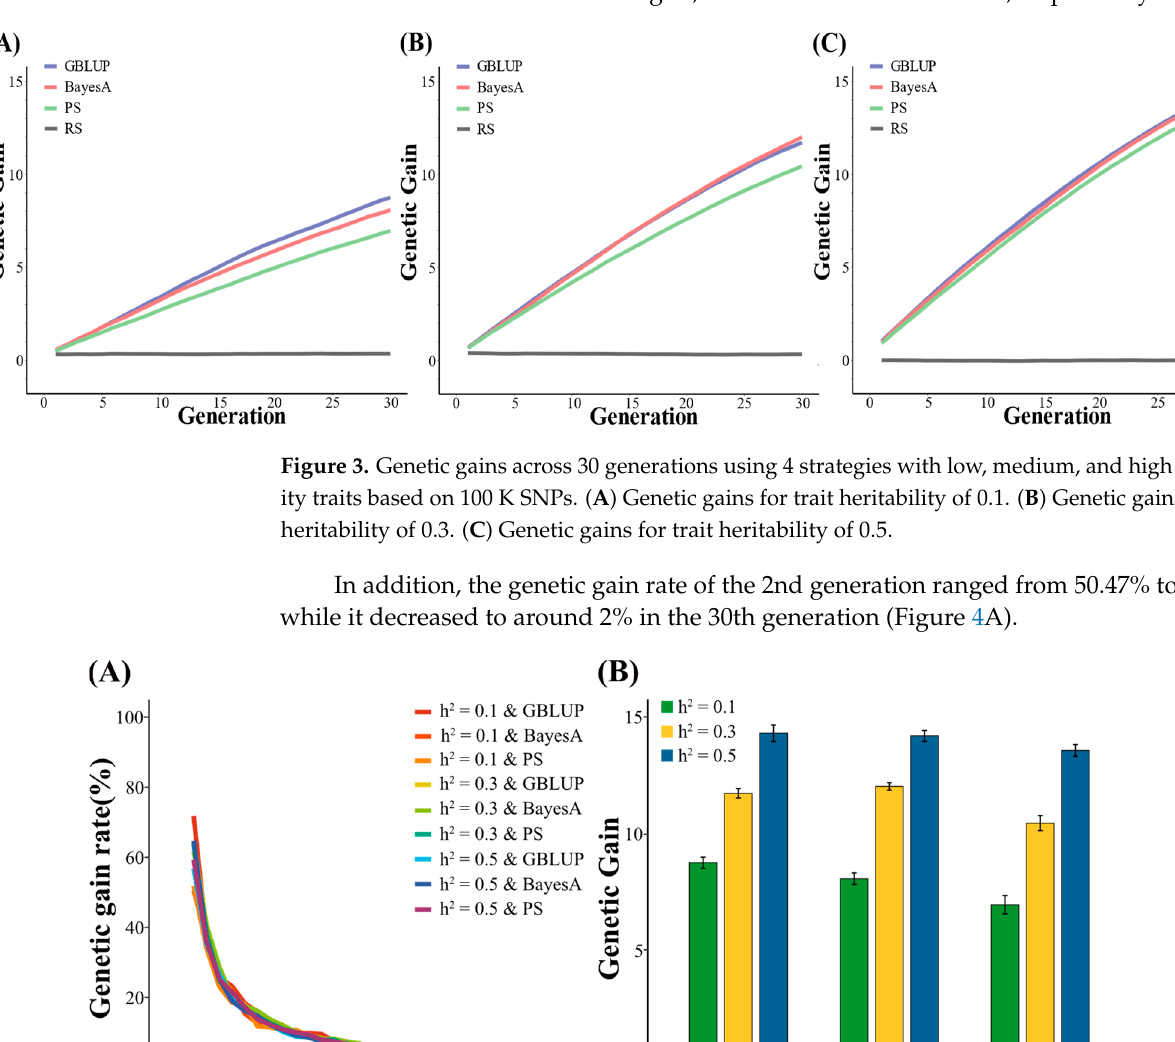
Figure 2. ( A ) Genetic gain rates across 30 generations for all scenarios using 54 K SNPs. ( B ) The genetic gains of the 30th generation based on 54 K SNPs for different heritabilities.